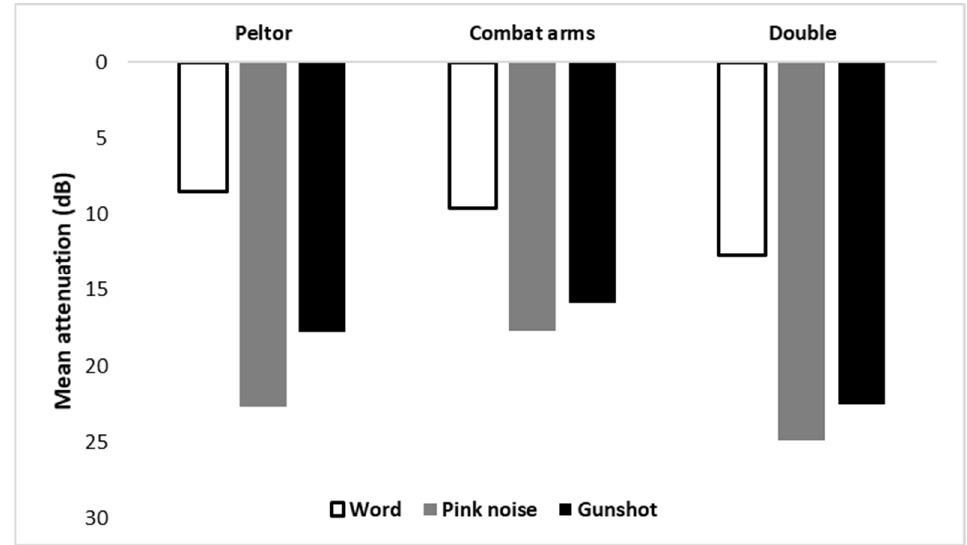
Figure 2. Mean attenuation of word, pink noise, and gunshot by HPD condition (Combat Arms ™ earplugs, Peltor ™ earmuffs, and double protection).